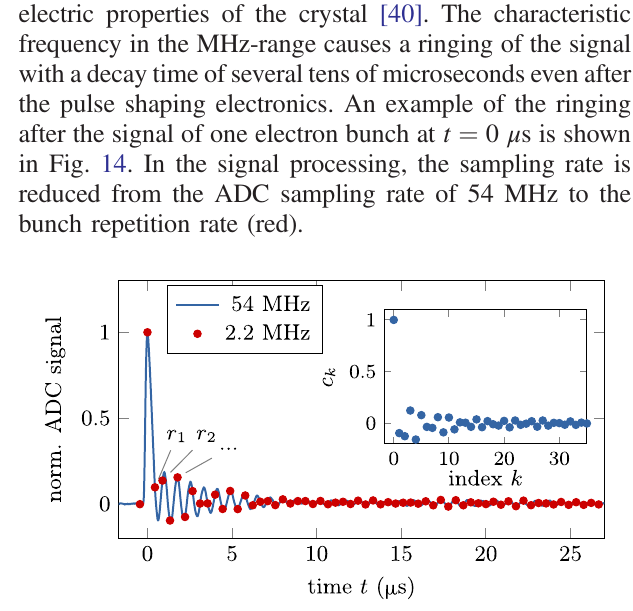
FIG. 14. Normalized signal of one pyroelectric detector of the CRISP spectrometer for a single bunch accelerated within the rf flat-top. Sampled with the ADC sampling rate (blue line) and reduced to the bunch repetition rate of 2.2 MHz (red points). The inset shows the entries of the correction